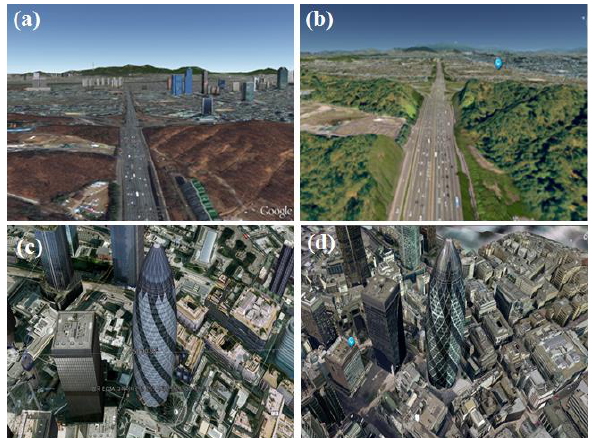
Figure 8. A Comparison of V-world with Google Earth. (a) and (c) Represent the Google Earth Services, (b) and (d) Represent the V-world